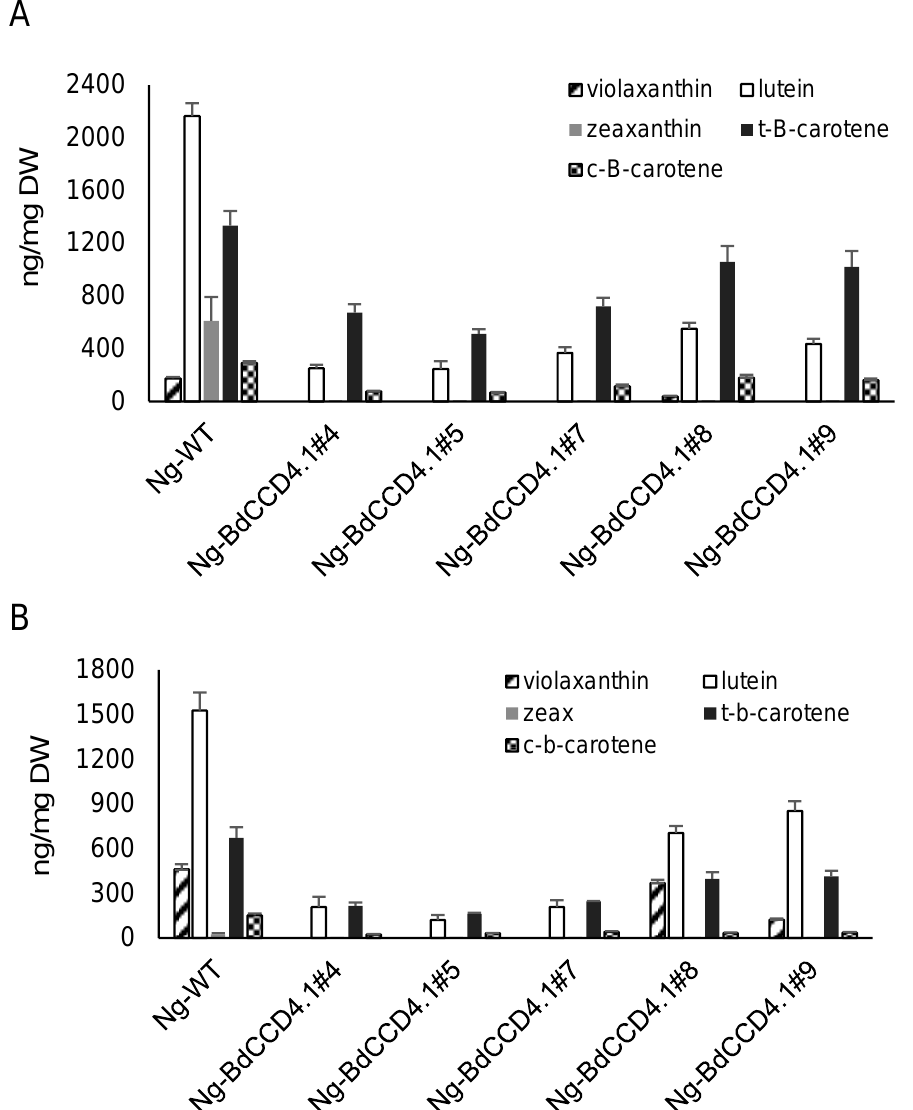
Figure 4. Accumulation of carotenoids in Wt and transgenic T1 lines of Nicotiana glauca transformed with BdCCD4.1. ( A ) Carotenoid levels in non-polar extracts of leaves from the Wt and transgenic lines of N. glauca . ( B ) Carotenoid levels in non-polar extracts of petals from the Wt and transgenic N. glauca . Analyses were conducted in triplicate. Error bars represent the SD. DW, dry weight.